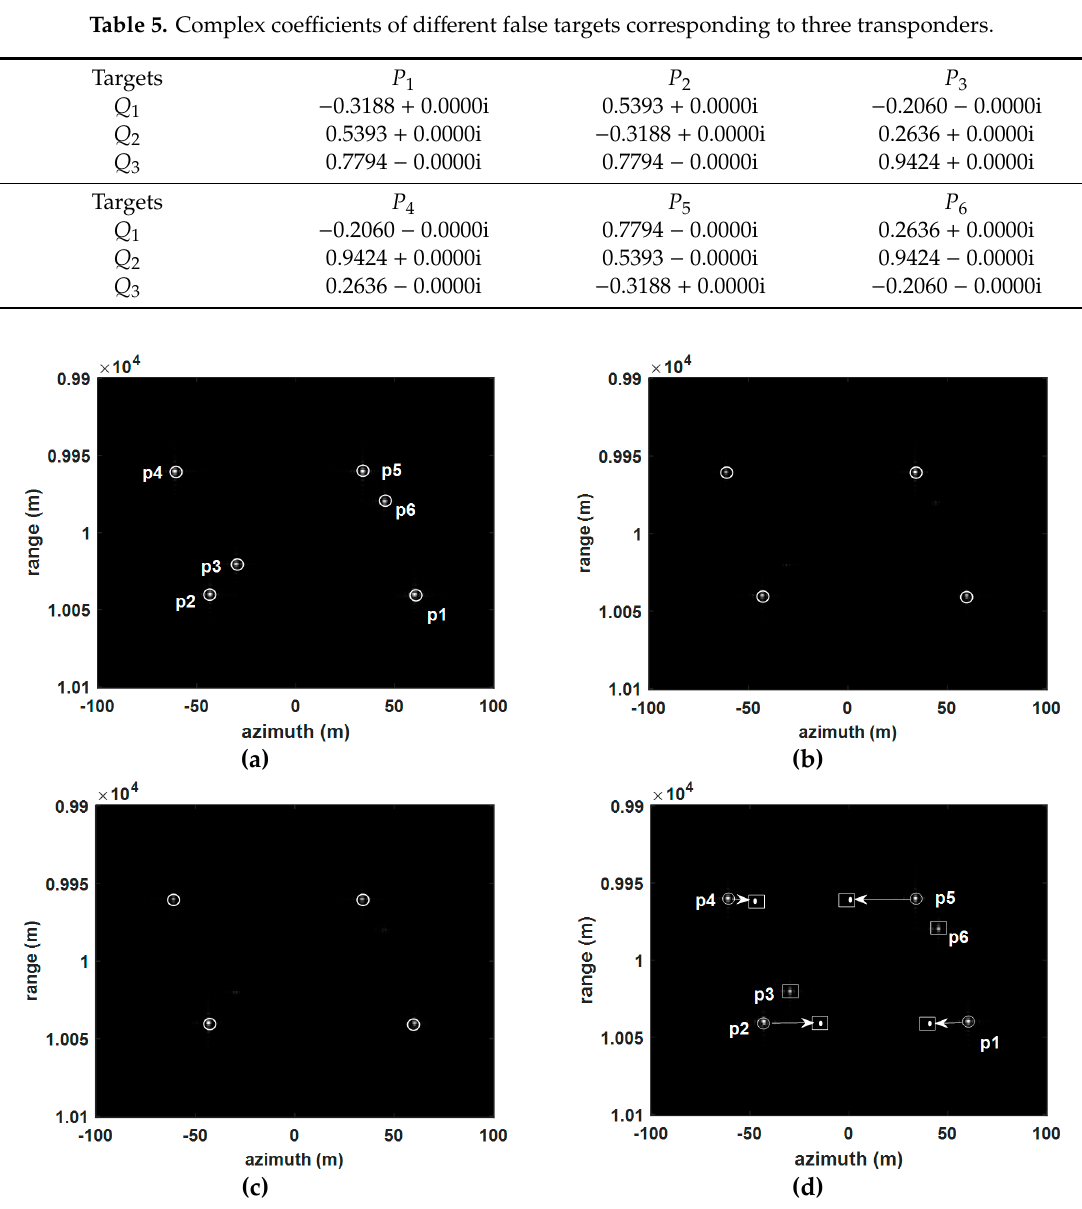
Figure 8. Simulations of false targets generated by three transponders. ( a ) is the SAR image of channel A 2 ; ( b ) is the result of the channel A 2 and A 3 DPCA operation; ( c ) is the result of the channel A 1 and A 2 DPCA operation; ( d ) is the relocation result.